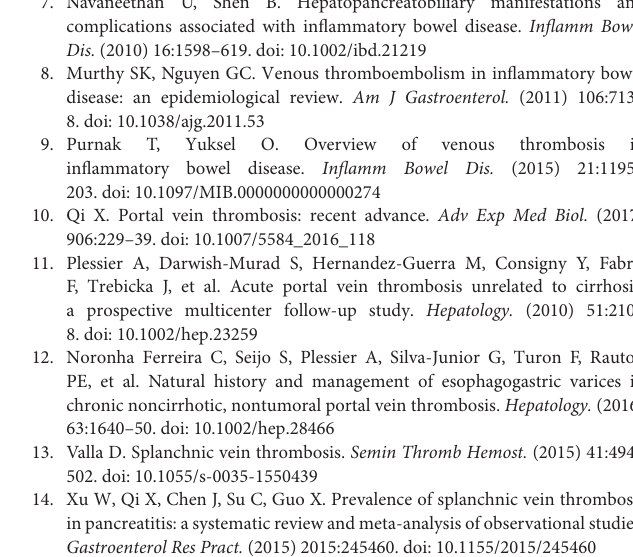
not located in one position. PVST, Portal venous system thrombosis; Pts, Patients. Supplementary Table 4 | Results of meta-regression analyses regarding the prevalence of PVST in IBD patients in whom the information regarding colorectal surgery was unclear. PVST, Portal venous system thrombosis; IBD, Inflammatory bowel disease; CD, Crohn’s disease. Supplementary Table 5 | Sensitivity analyses in studies where the information regarding colorectal surgery was unclear. CI, Confidence interval; CD, Crohn’s disease; IBD, Inflammatory bowel disease. Supplementary Table 6 | Characteristics of included patients with PVST after colorectal surgery ( n = 789). a PVST was not located in one position. b The hematological abnormalities in the four patients were thrombocytosis, G20210A prothrombin mutation, antithrombin III mutation and anti-phospholipid syndrome, respectively. PVST, Portal venous system thrombosis; Pts, Patients. Supplementary Table 7 | Results of meta-regression analyses regarding the incidence of PVST in patients after colorectal surgery. PVST, Portal venous system thrombosis; UC, Ulcerative colitis; USA, United States of America; IBD: Inflammatory bowel disease. Supplementary Table 8 | Sensitivity analyses in studies where the information regarding colorectal surgery was clear. CI, Confidence interval; UC, Ulcerative colitis; IBD, Inflammatory bowel disease. Supplementary Table 9 | Univariate analysis of risk factors for PVST in IBD patients after colorectal surgery. PVST, Portal venous system thrombosis; IBD, Inflammatory bowel disease; TAC, Total abdominal colectomy; CP, Completion proctectomy; TPC, Total proctocolectomy; IPAA, Ileal pouch-anal anastomosis; RPC, Restorative proctocolectomy; ASA, American Society of Anesthesiologists classification. Supplementary Table 10 | Multivariate analysis of risk factors for PVST in IBD patients after colorectal surgery. PVST, Portal venous system thrombosis; IBD, Inflammatory bowel disease; RPC, Restorative proctocolectomy; IPAA, Ileal pouch-anal anastomosis; CP, Completion proctectomy; TAC, Total abdominal